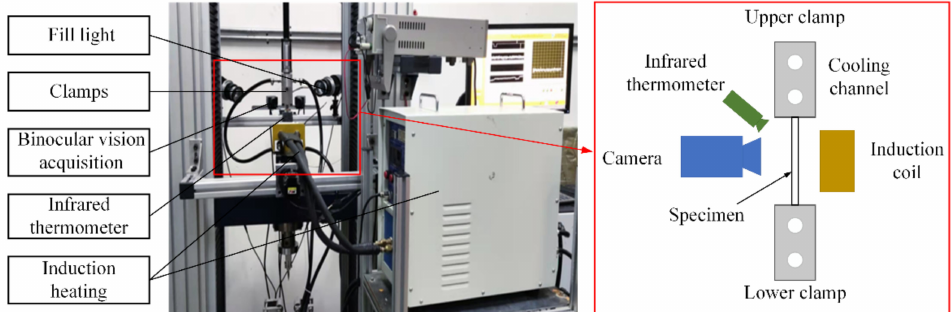
Figure 2. Experimental platform of the hot tensile